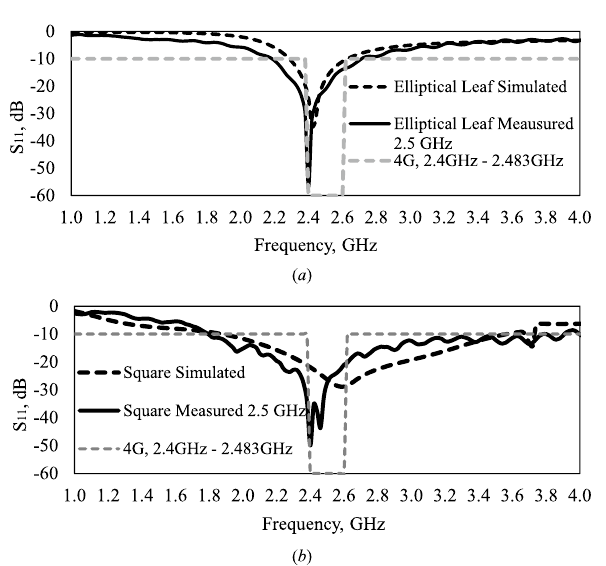
Figure 3. Comparison of simulated performed in Ansys 2016 and measured results of directional monopole antennas: ( a ) elliptical leaf; ( b ) square